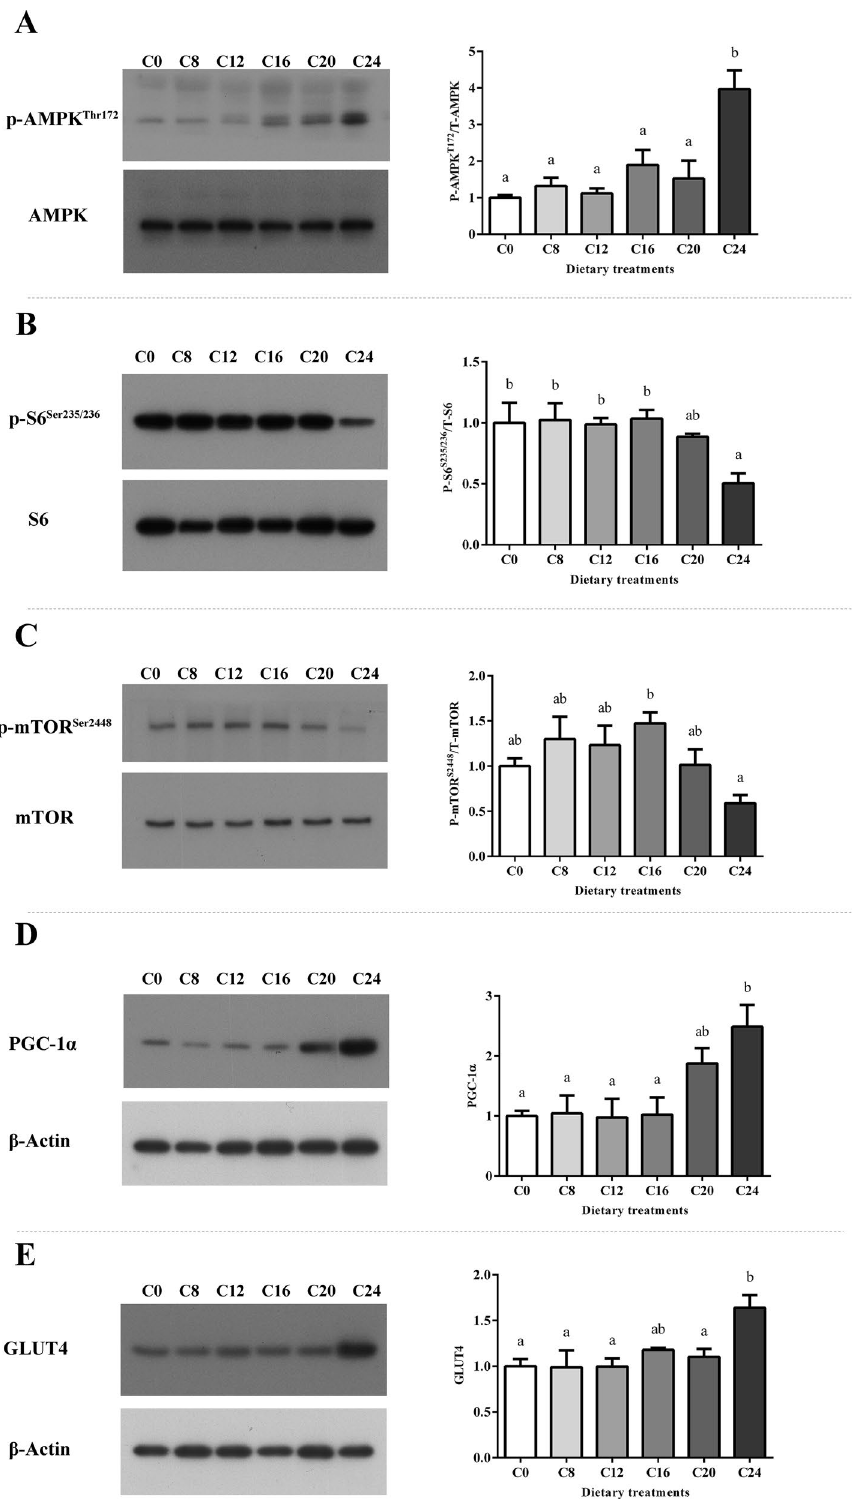
Figure 4. The levels and phosphorylation of AMPK ( A ), S6 ( B ) and mTOR ( C ), and the levels of PGC-1α ( D ) and GLUT4 ( E ) were examined by western blots and quantitated. Results are represented as mean ± SE. Values with different letters means significant differences ( P < 0.05, Tukey’s